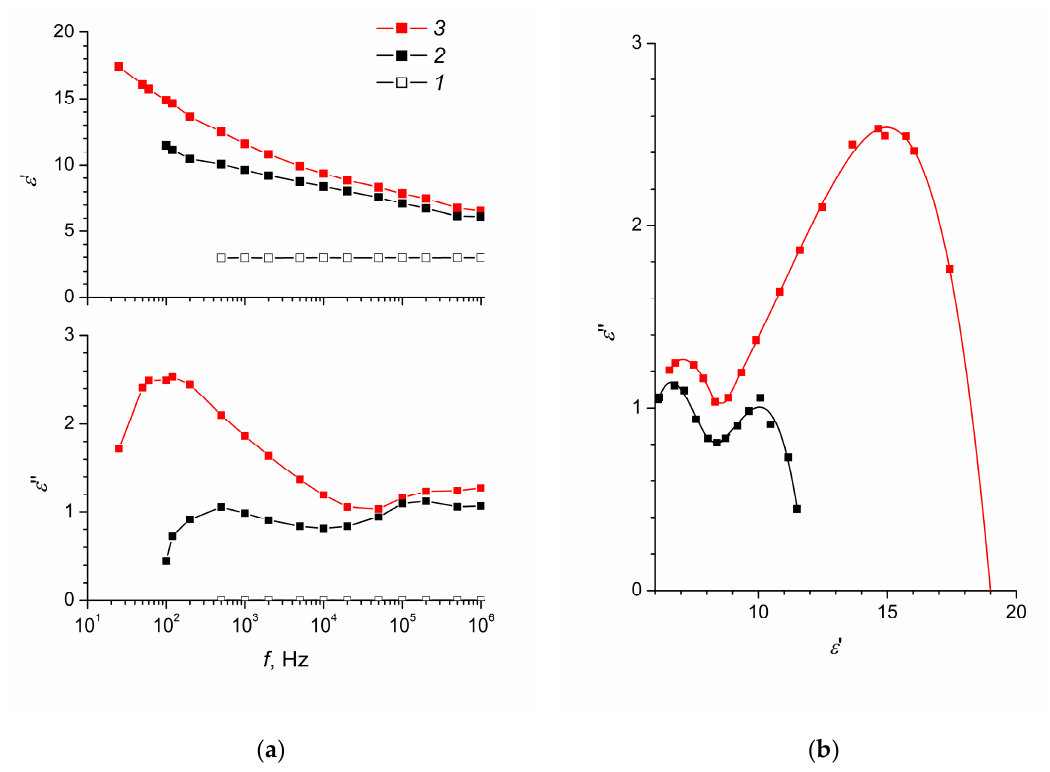
Figure 2. ( a ) The dielectric constants ( ε ’, ε ”) as functions of frequency and ( b ) Cole–Cole diagrams for ( 1 ) unfilled elastomer, ( 2 ) MnO 2 -0 and ( 3 ) MnO 2 -E samples.